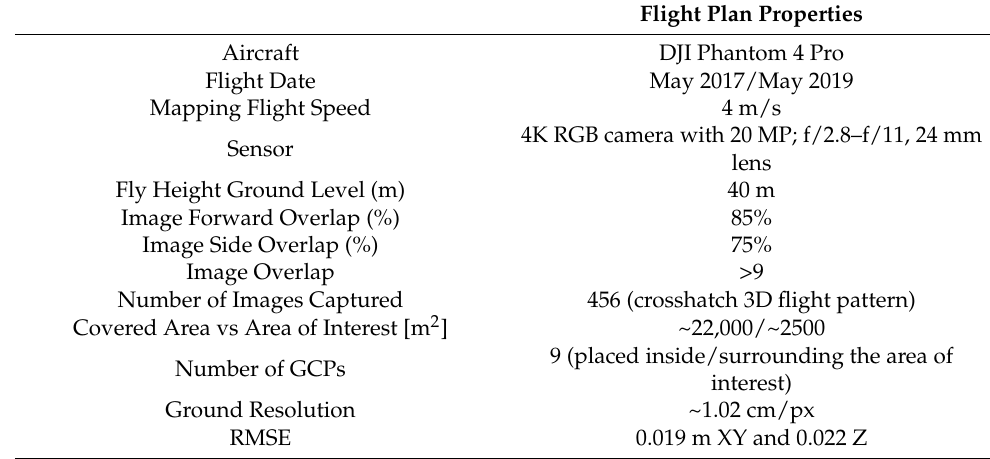
Table 1. UAV and flight